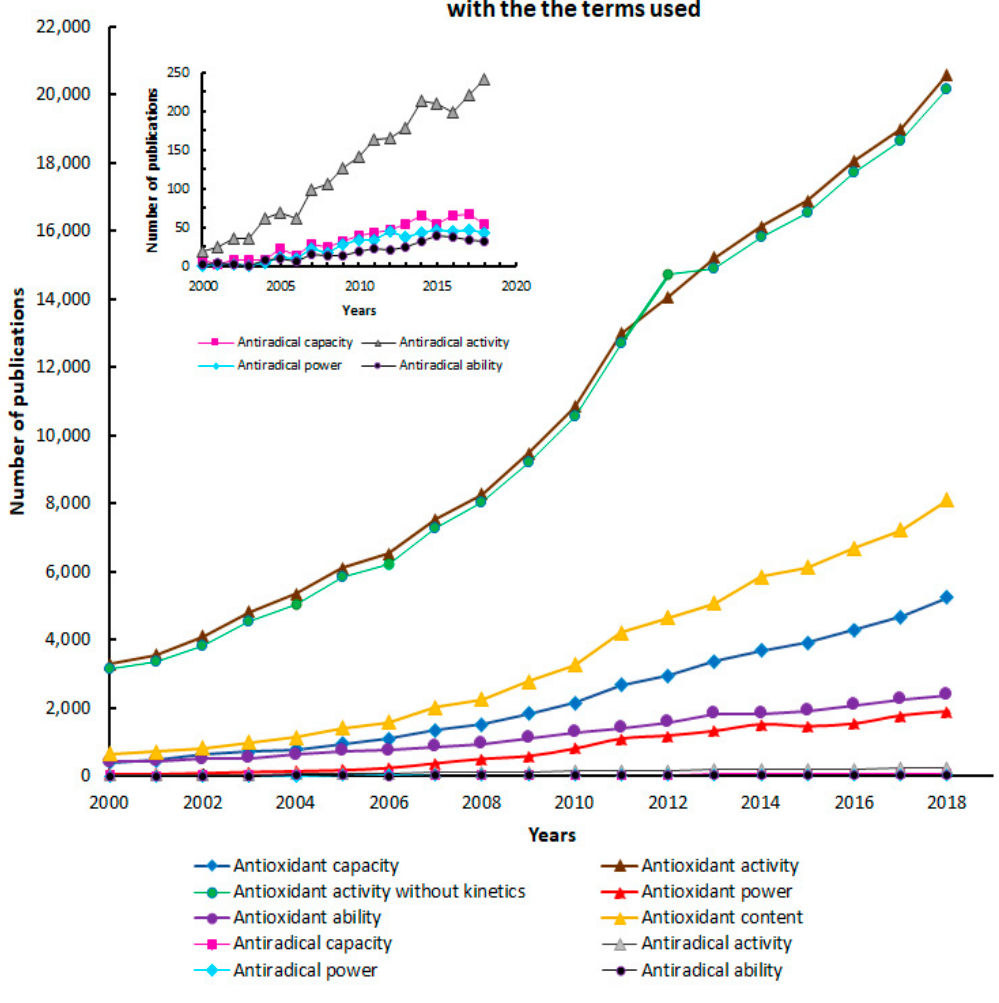
Figure 1. Use of terms in 2000–2018.